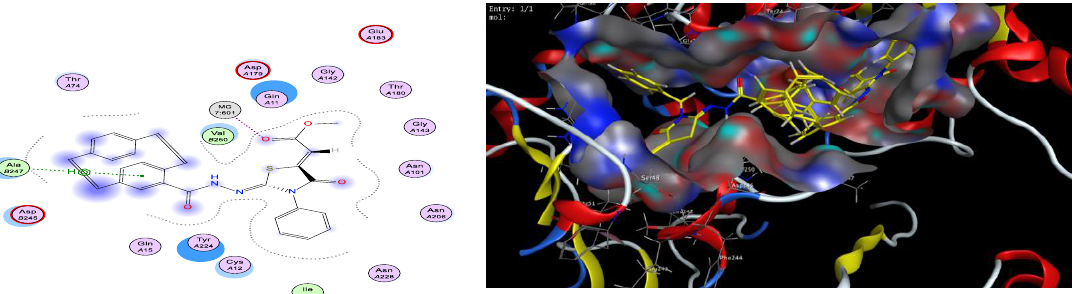
Figure 15. The two- and three-dimensional (2D and 3D) diagrams illustrate the binding mode of the reference colchicine interacting with the colchicine binding site of β-tubulin.